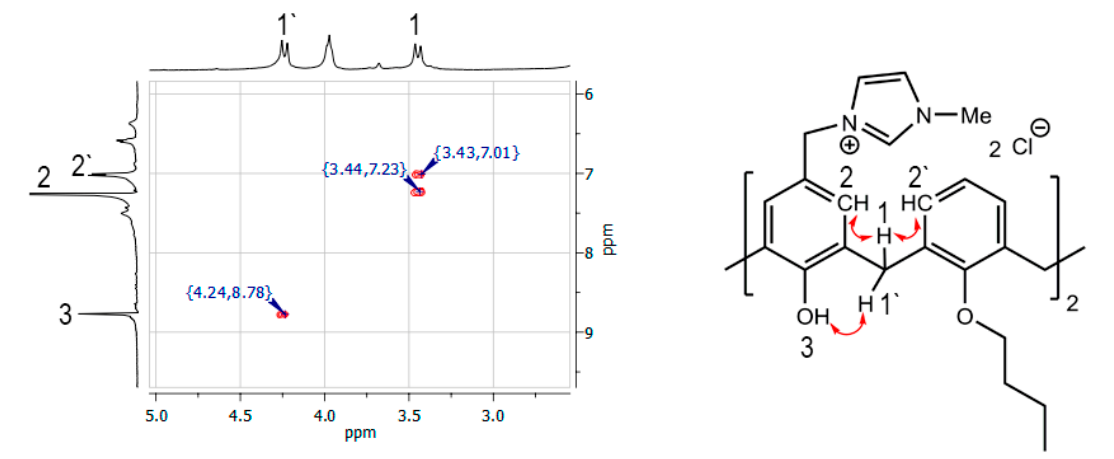
Figure 1. Fragment of the 1 H- 1 H NOESY NMR spectra of 5 (CDCl 3 ).